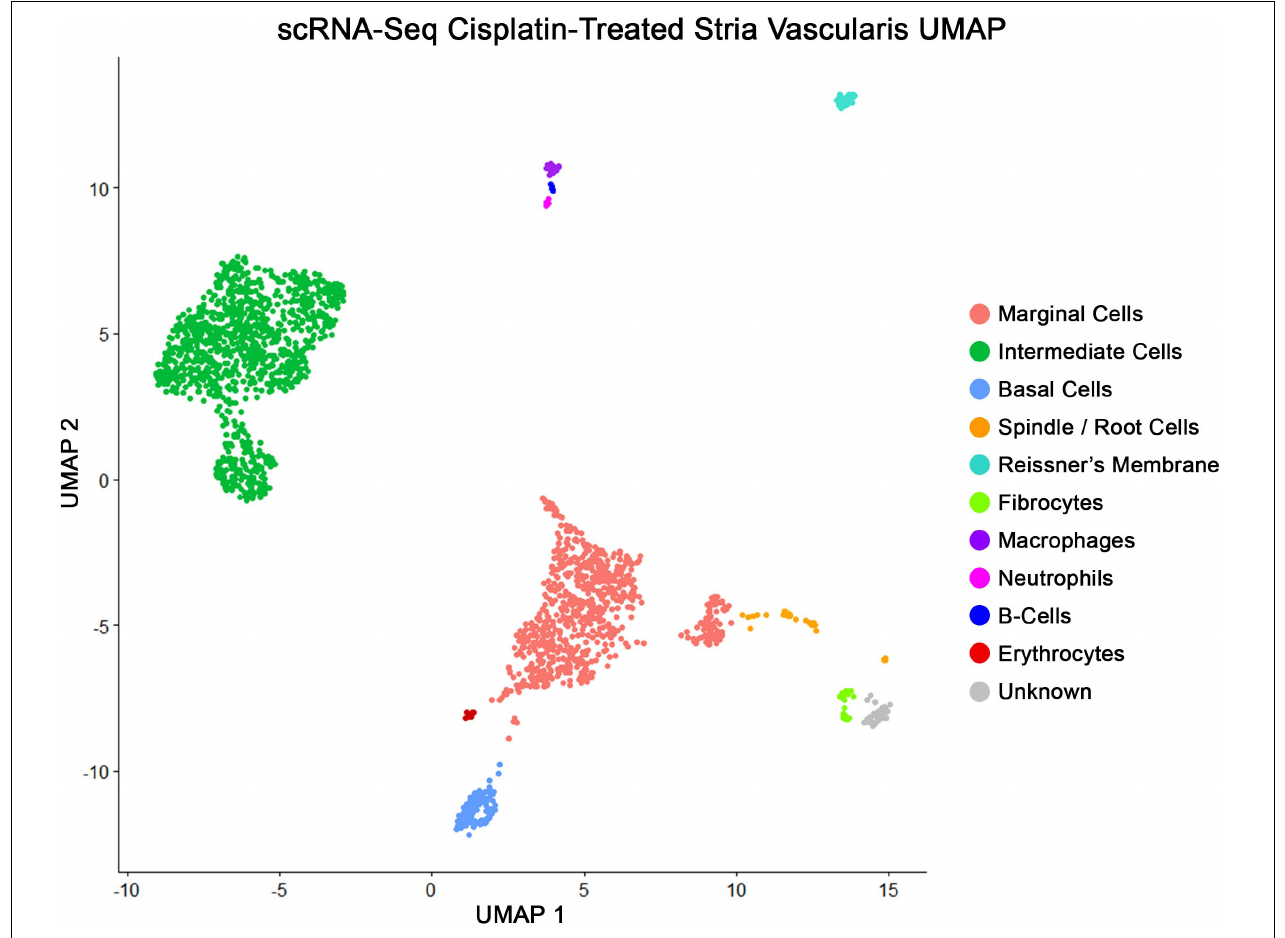
FIGURE 4 | scRNA-Seq of cisplatin-treated adult SV demonstrates all the expected cell populations as untreated adult SV. Uniform manifold and projection (UMAP) clusters identified using published markers, showing marginal, intermediate, and basal cells in pink, green, and blue, respectively. Each dot represents a single whole cell. Additional cell types identified were spindle cells, fibrocytes, Reissner’s membrane cells, neutrophils, B-cells, macrophages, and red blood cells (RBCs).